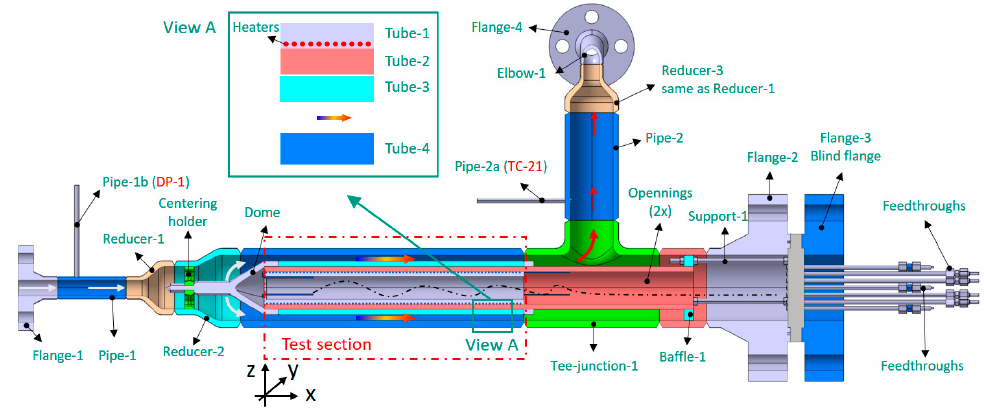
Figure 4. Naming of mockup.